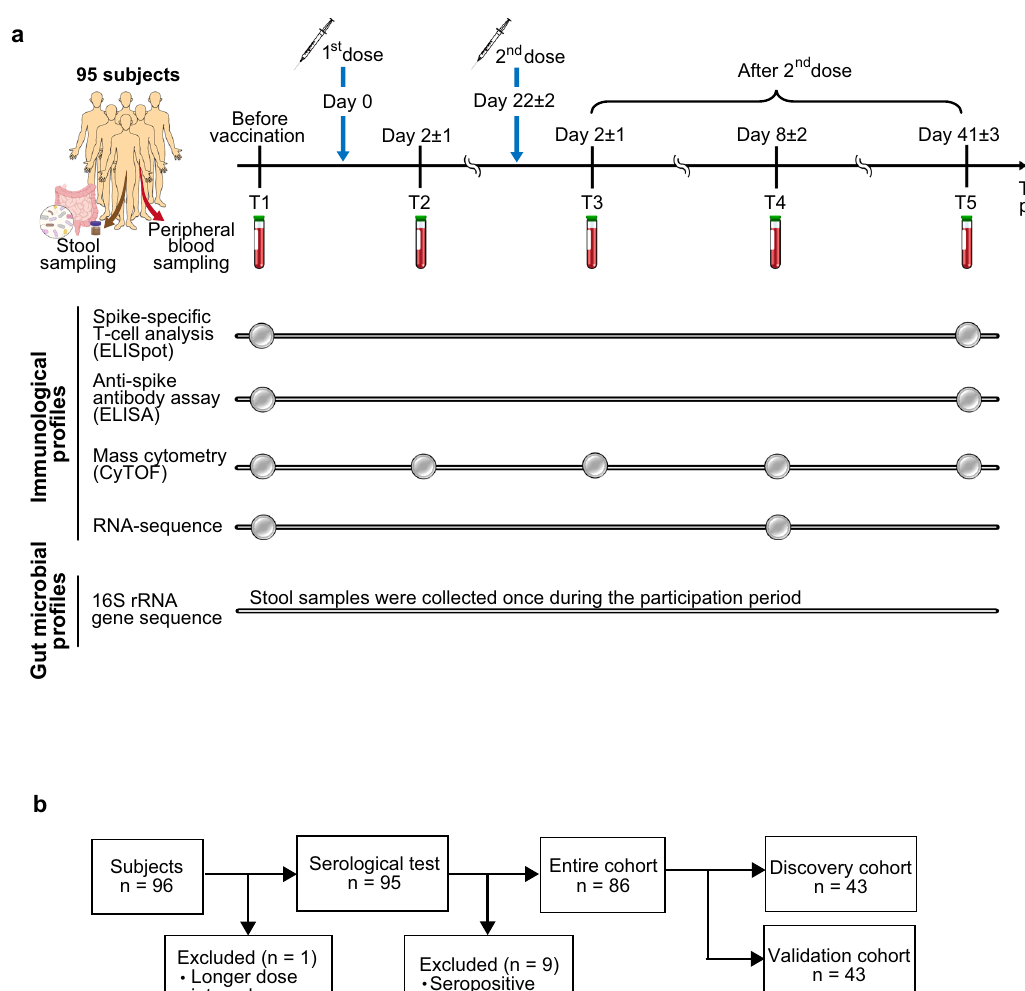
Fig. 1 Study design. a Schematic diagram showing blood and stool sample collection and analysis performed in this study. Samples from 95 subjects who received two doses of BNT162b2 at 3 – 4-week intervals were analyzed. b Schematic diagram showing data analysis approaches. The entire cohort (86 subjects who were seronegative for SARS-CoV-2 spike at baseline) were divided into the discovery and validation cohorts ( n = 43 each). The discovery cohort or entire cohort was used to identify factors associated with COVID-19 antibody or T-cell responses, and factors identi fi ed in the discovery cohort were subjected to con fi rmation in the validation